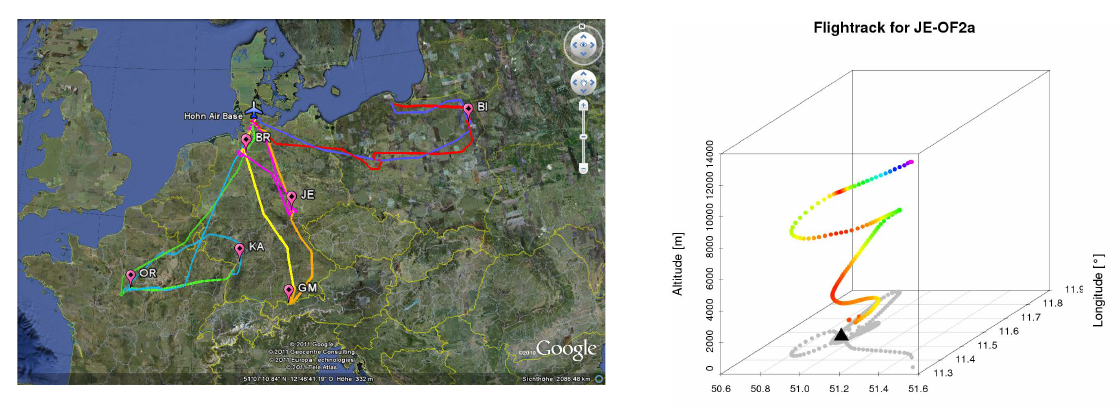
Fig. 1. FTS locations and aircraft flight tracks of the IMECC cam- paign. The aircraft was stationed at a military airbase near Hohn in northern Germany. Details about the individual FTS sites are listed in Table 1.